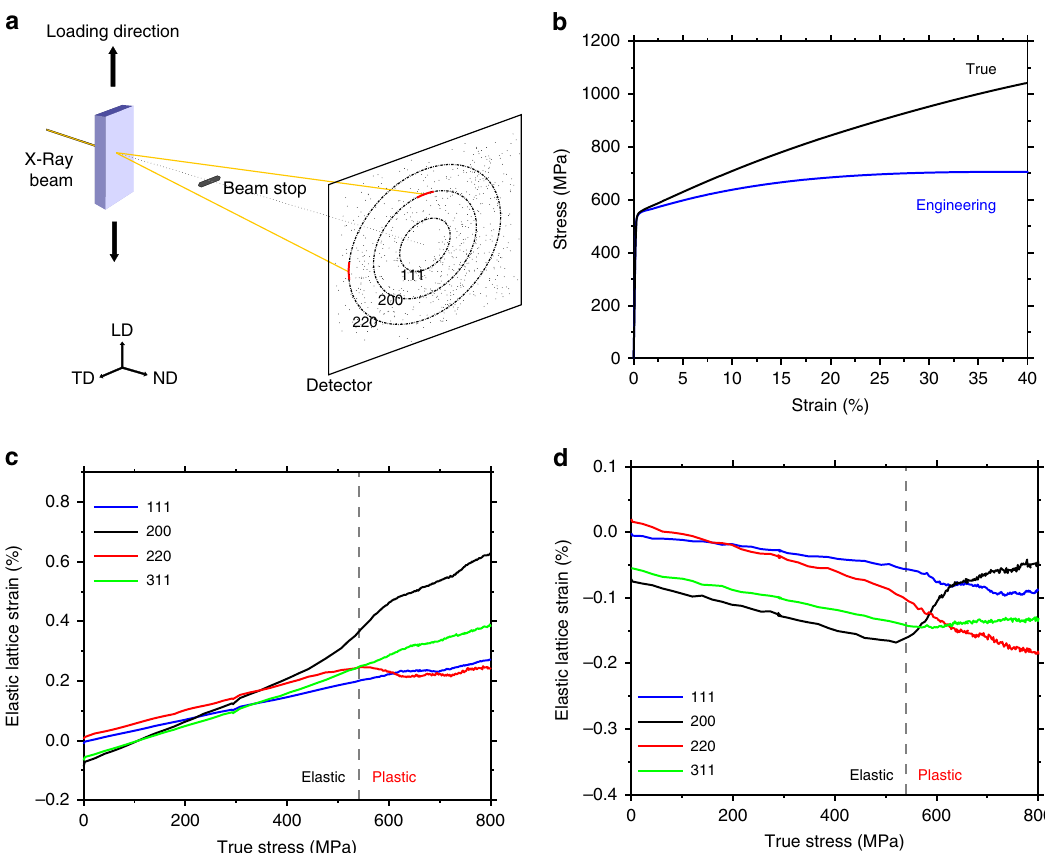
Fig. 2 Lattice strain behaviour of an AM 316 stainless steel sample measured via in situ SXRD. a Schematic of in situ SXRD setup, where the loading direction (LD), transverse direction (TD) and normal direction (ND) are illustrated. b Engineering and true stress – strain curves of uniaxial tension, plotted up to the onset of necking. c In situ SXRD results of the lattice strain ( ɛ hkl ) along LD in four grain families of {111}, {200}, {220} and {311}, respectively, plotted against the macroscopic true stress of the sample. The 0.2% offset yield strength ( σ Y ) is marked with a dashed line, separating the elastic and plastic regimes. The average statistical uncertainty of the calculated strains is about 0.01%. d Same as c , except along